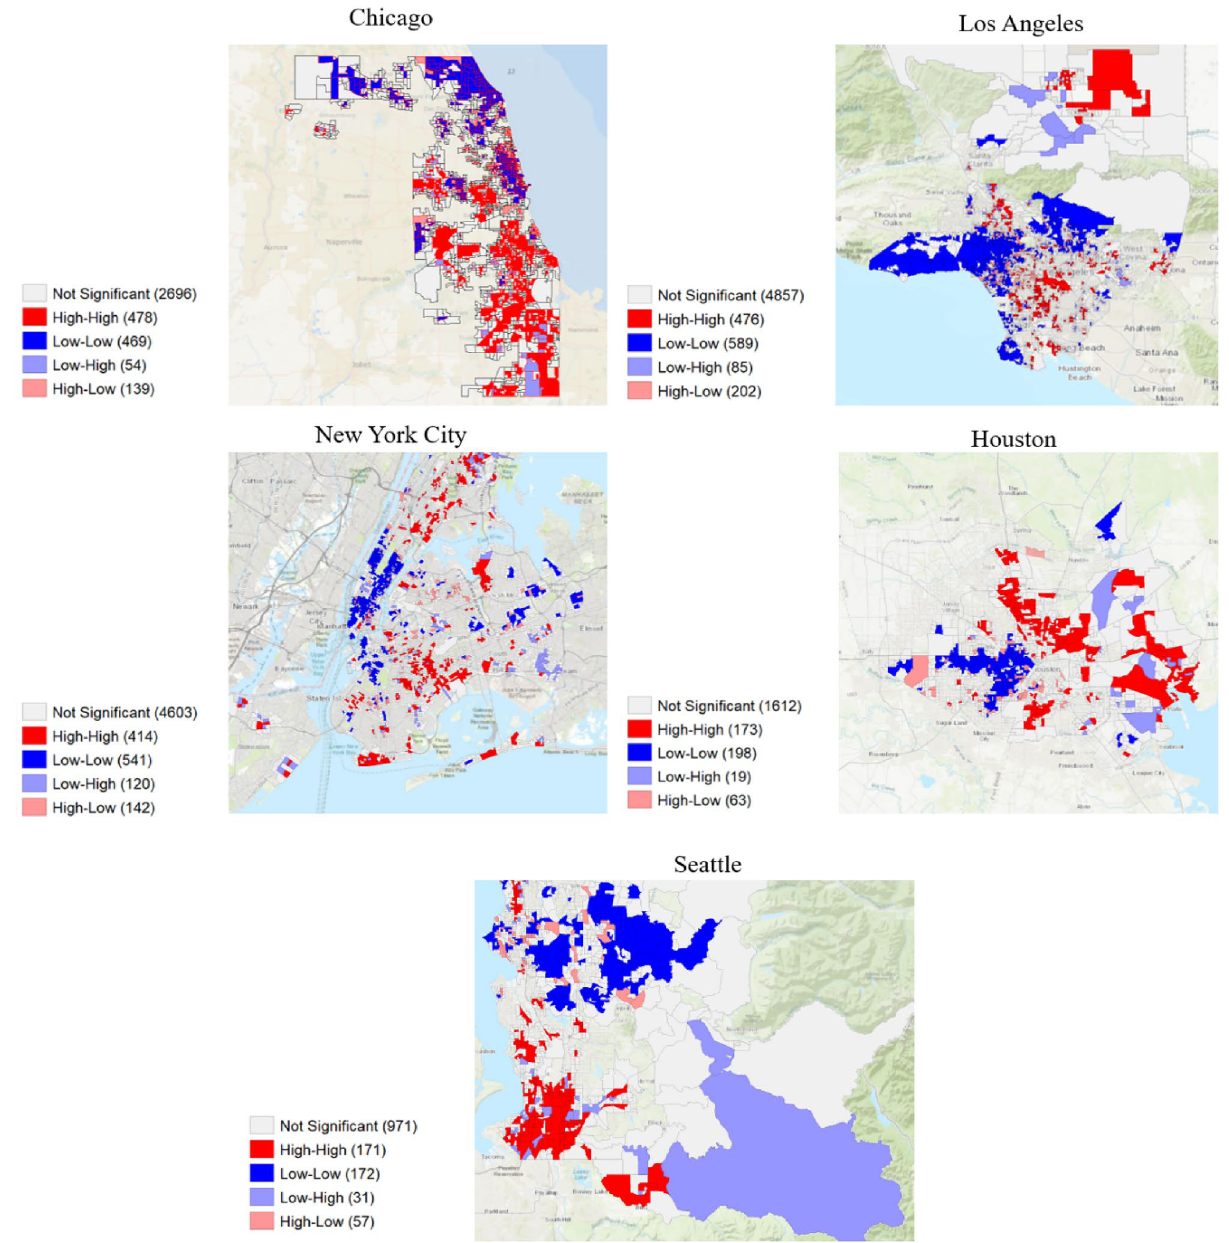
Figure 6. Visualization of exposure risk of the median income levels of cbgs on the POI-CBG network. Spatial clusters are statistically significant for p < 0.05 with the median income levels percentage change from the baseline at week 14. H–H (High–High) clusters are represented by the darkest shade of red and L–L (Low–Low) are represented by the darkest shade of blue. The authors used open-source GeoDa Software (https:// geoda center. github. io/, 1.20.0.0) for calculations and maps 50